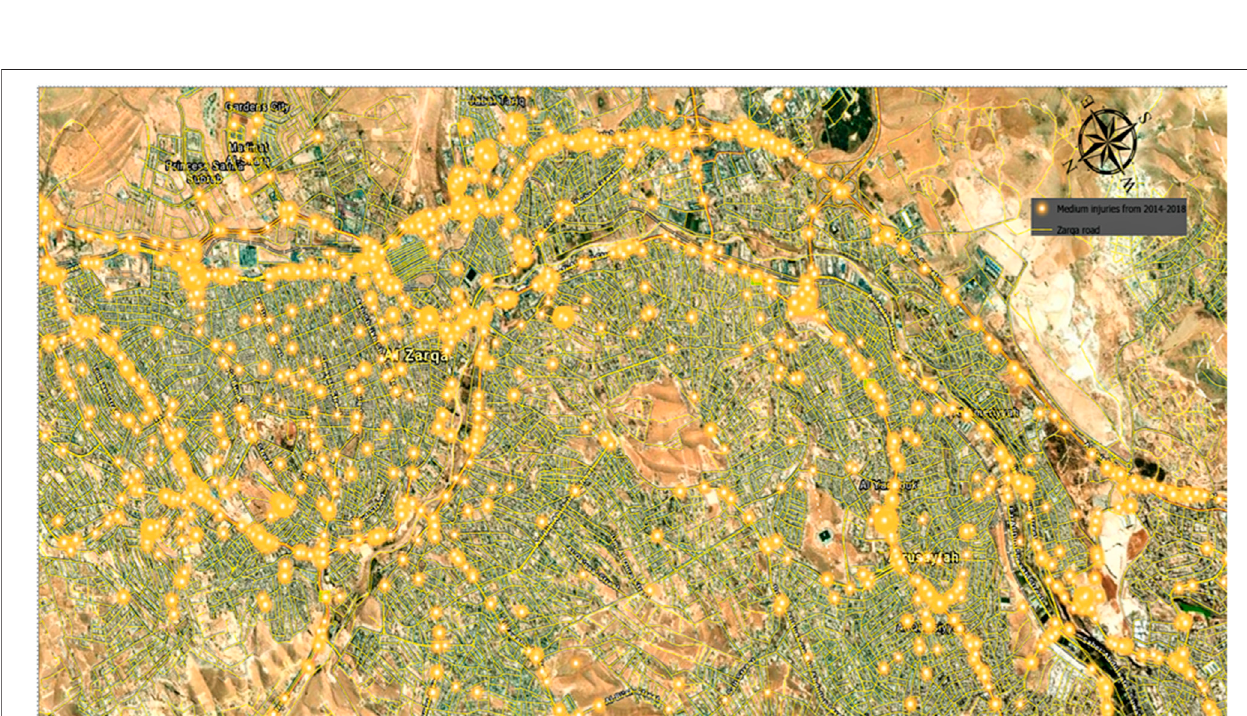
FIGURE 7 | Slight injuries crashes for Zarqa City in 2014 –– 2018.